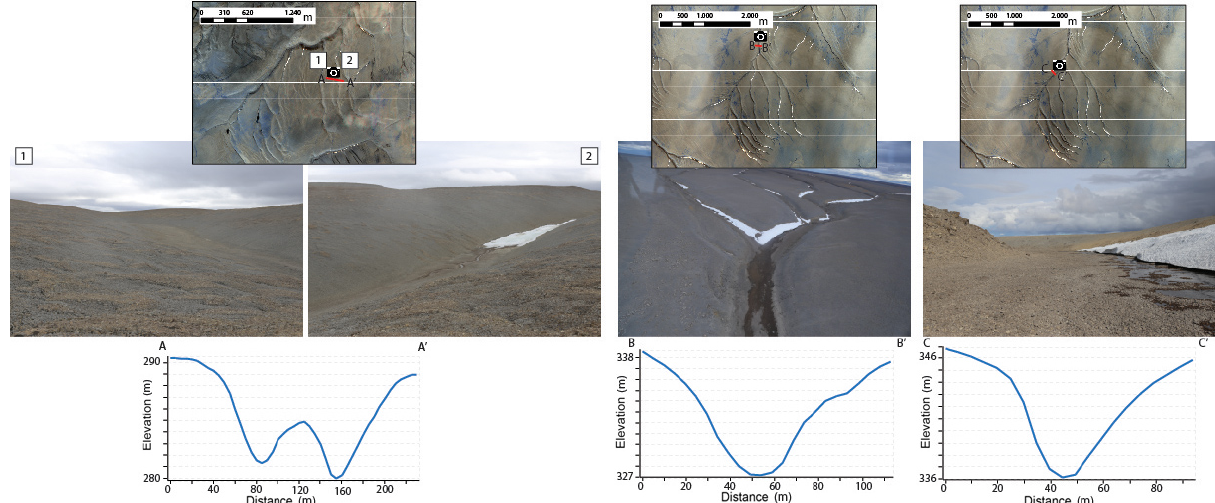
Figure 8. Cross-section field imagery and profiles. Upper row shows a satellite imagery context on the location where the image and the cross section are obtained, together with a scale reference. Middle row shows images of four cross sections, obtained by this expedition on 24 and 25 July 2017. The middle panel corresponds to a main channel whereas the other three images correspond to tributaries. Cross-section profiles below show elevation (m) vs. distance (m) obtained from the Arctic DEM at 2mpixel − 1